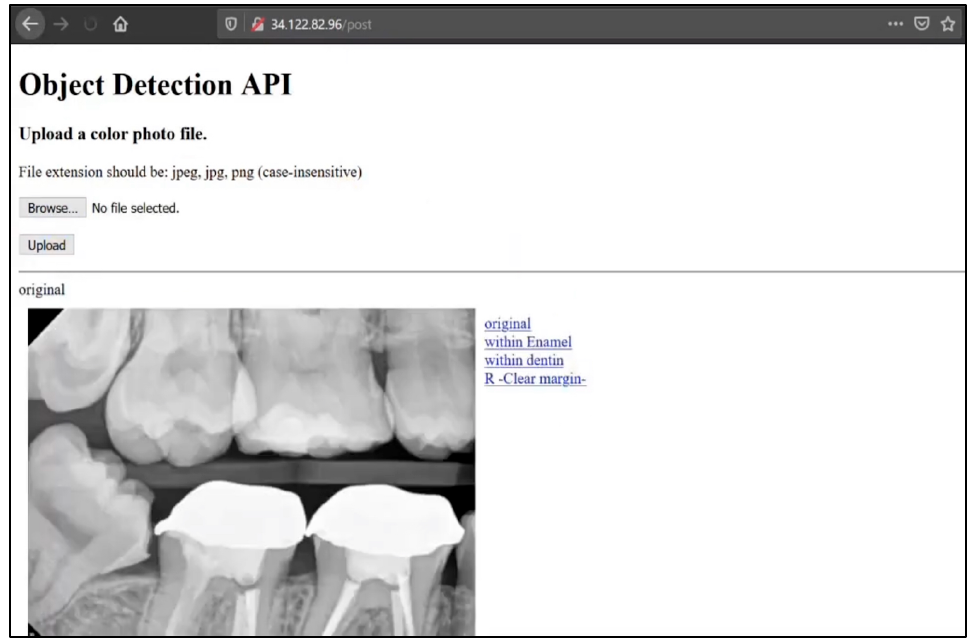
Figure 3. The model’s interface (an unseen radiograph was uploaded through the interface and the model detected three errors of different classes: within enamel, within dentin, and within restoration (clear margins)).